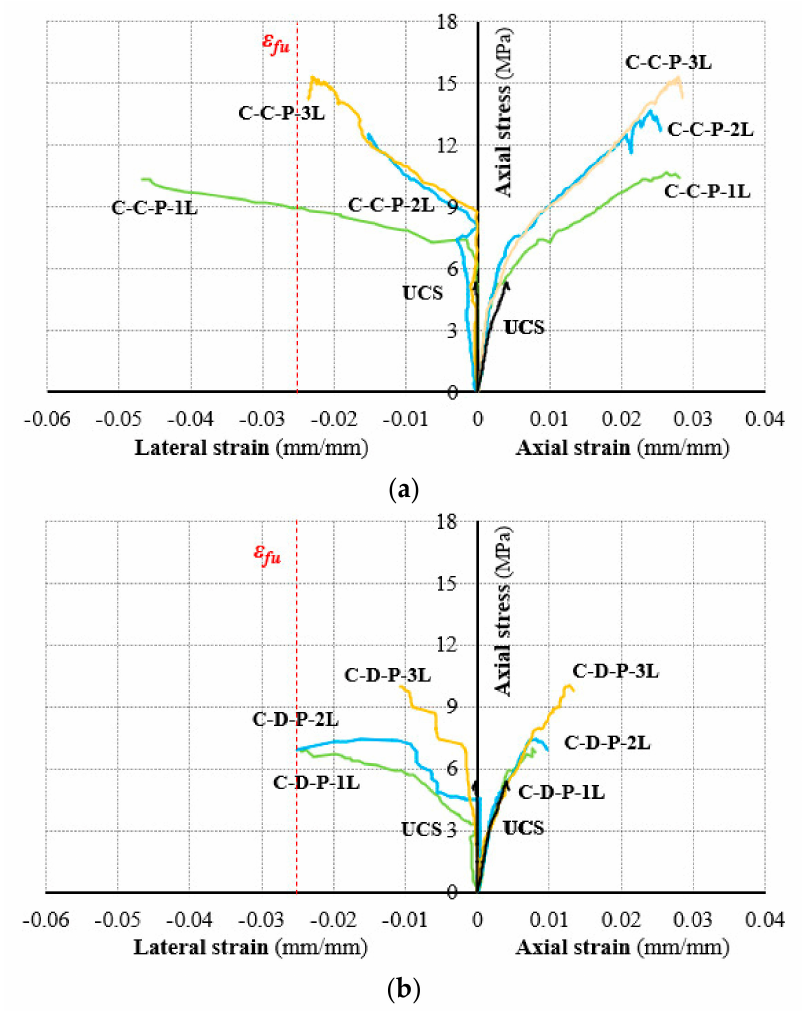
Figure 7. Experimental axial stress–strain curves: ( a ) continuous and ( b ) discontinuous confined